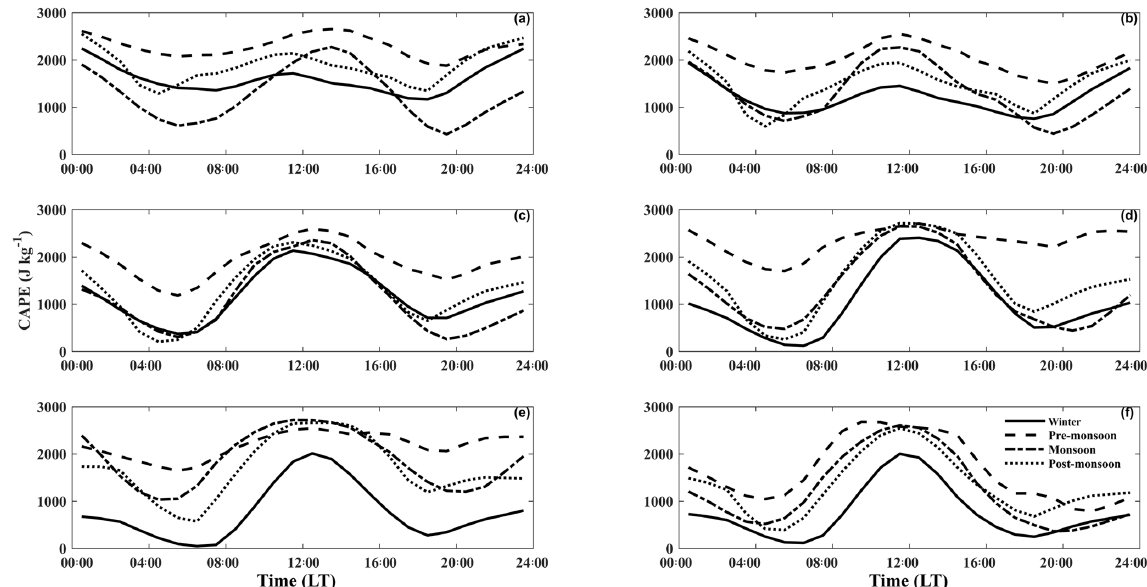
Figure 9. Diurnal variation of CAPE (Jkg − 1 ) over the (a) AS, (b) BoB, (c) SP, (d) CI, (e) NI, and (f) NE regions of India during four